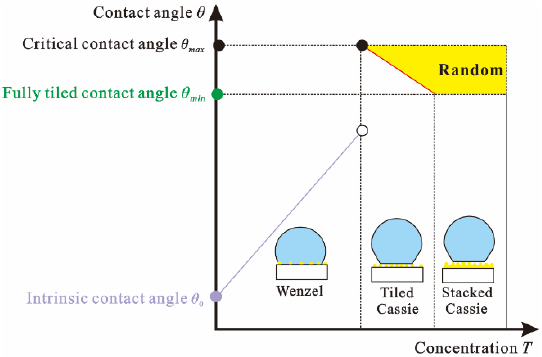
Figure 6. Effect of hydrophobic nano-SiO 2 particle concentration on wetting state.